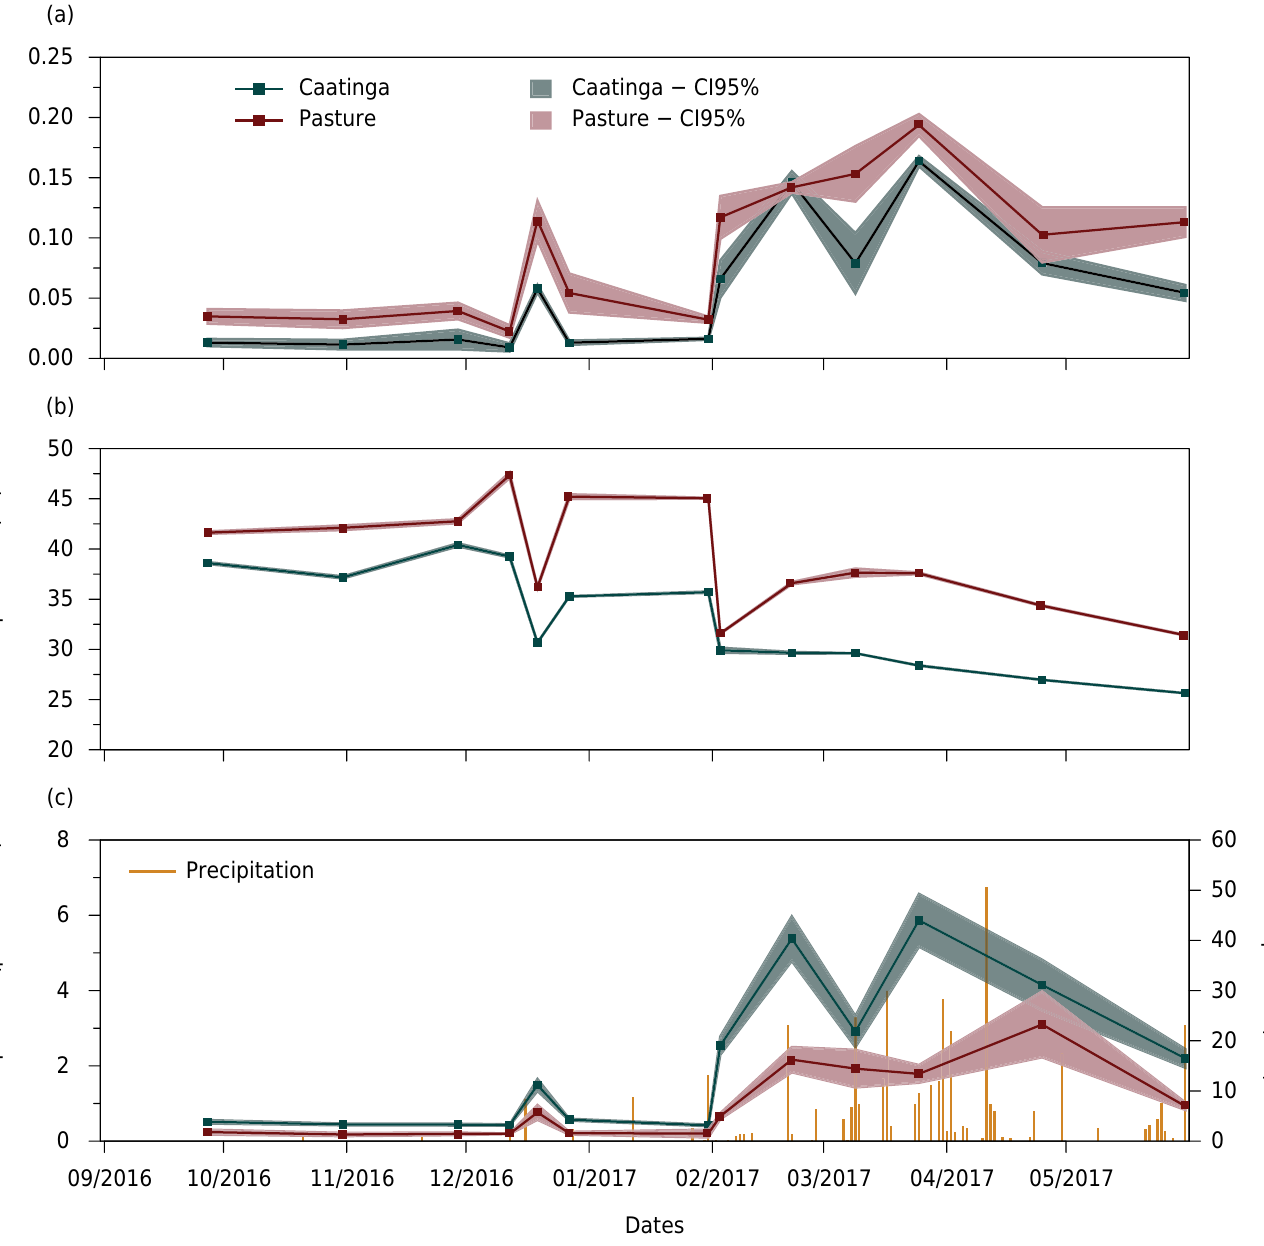
Figure 3. Soil volumetric moisture (θv), soil temperature (Ts), and soil respiration (SR) of the Caatinga and degraded pasture areas over experimental time. The shaded area represents the mean intervals at a confidence level of 95 % (CI95%) calculated bootstrapping the samples for each measurement over the time.